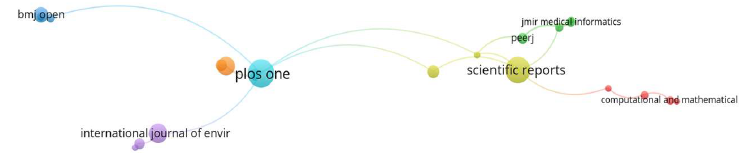
Figure 12. Author citations by journal.